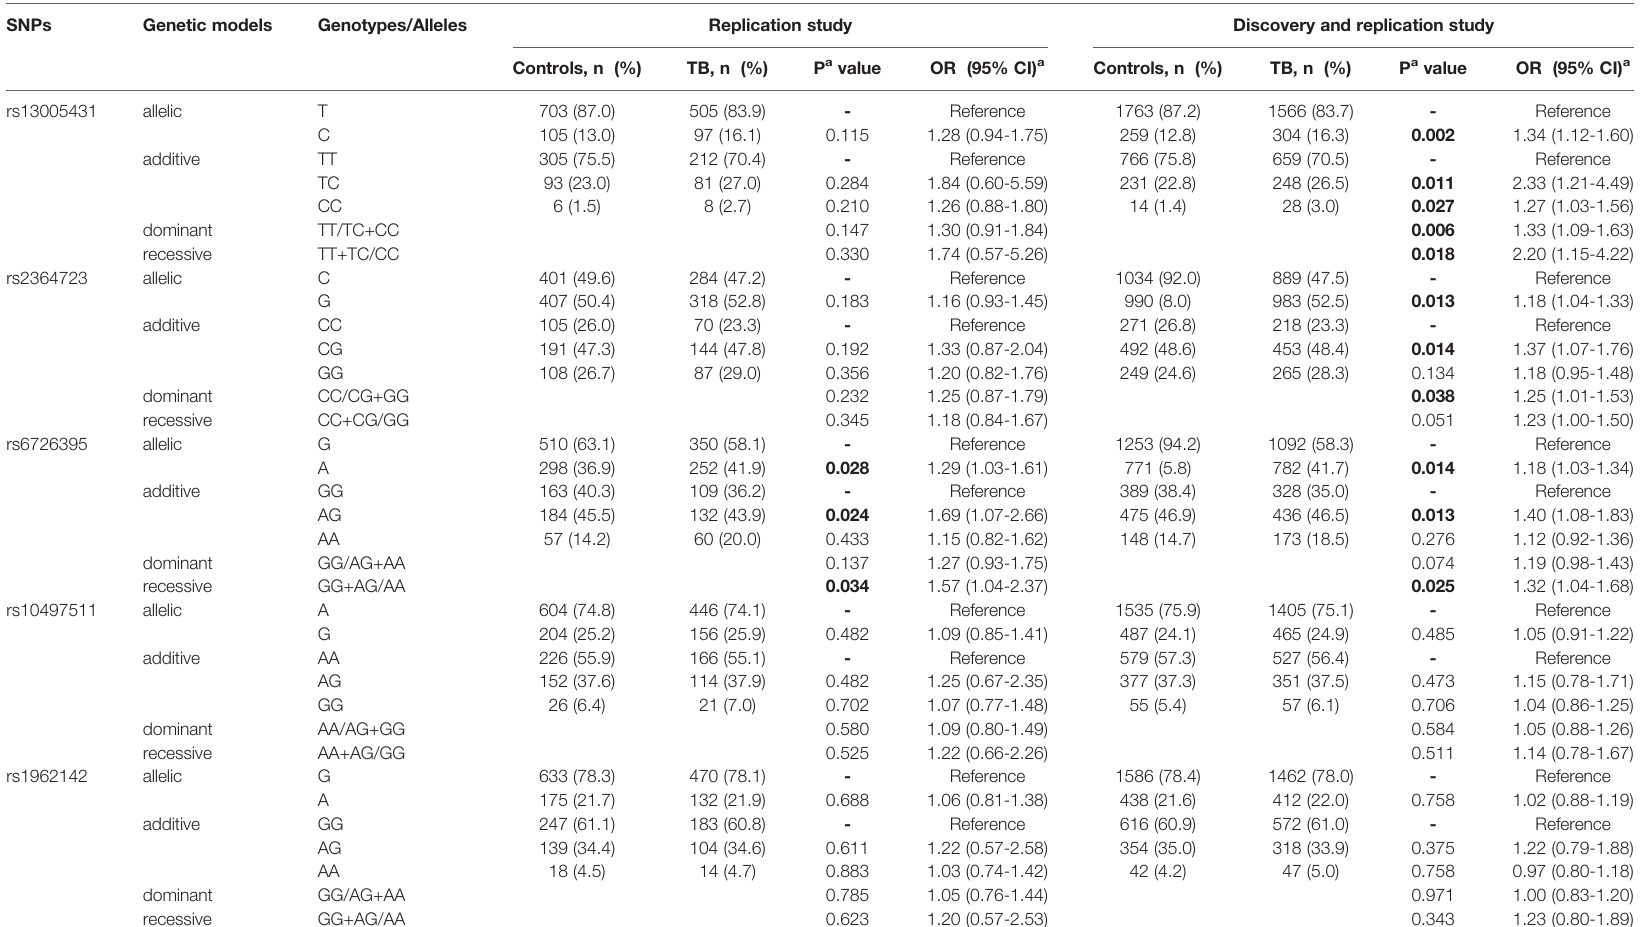
TB, tuberculosis; OR, odds ratio; CI, con fi dence interval; allelic, allelic model; additive, additive model; dominant, dominant model; recessive, recessive model. a Adjusting for cofounders including age and gender in a binary logistic regression analysis model. Bold values: P-value <